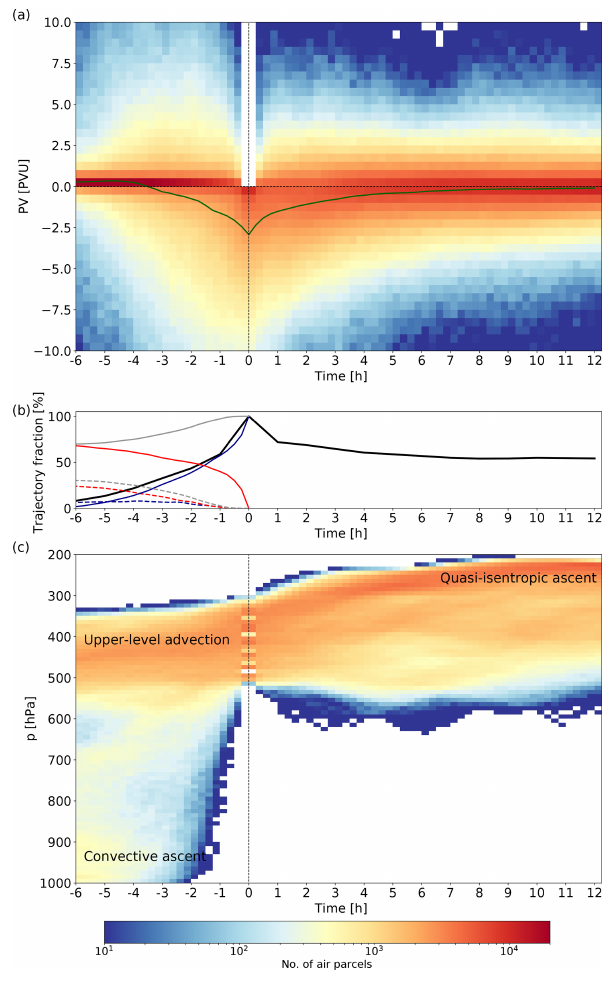
Figure 12. (a) A 2-D histogram of temporal evolution of PV (in PVU) for forward and backward trajectories initialized in a re- gion of convectively produced negative PV between 315 and 325K at 09:00UTC, as shown in Fig. 11a (pink shading). The time is given relative to the trajectory start at 09:00UTC. The green line shows PV averaged over all trajectories (in PVU). (b) Fraction of trajectories with a negative PV value (black, in %), the fraction of trajectories located above 600hPa (solid grey, in %) and below 600hPa (dashed grey, in %). Additionally, the fraction of trajecto- ries with negative PV above 600hPa (solid blue, in %) and below 600hPa (dashed blue , in %) and the fraction of trajectories with positive PV above 600hPa (solid red, in %) and below 600hPa (dashed red, in %) are shown. Note that after t = 0h the majority of trajectories is located above 600hPa. Panel (c) is the same as (a) but for pressure (in